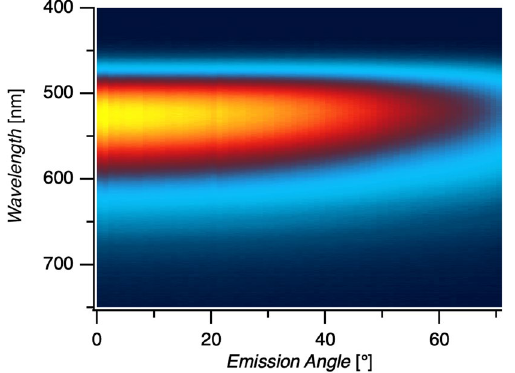
Figure 5. ARES data for an Alq 3 OLED of 100 nm thickness on an ITO substrate driven at 33 mA/cm 2